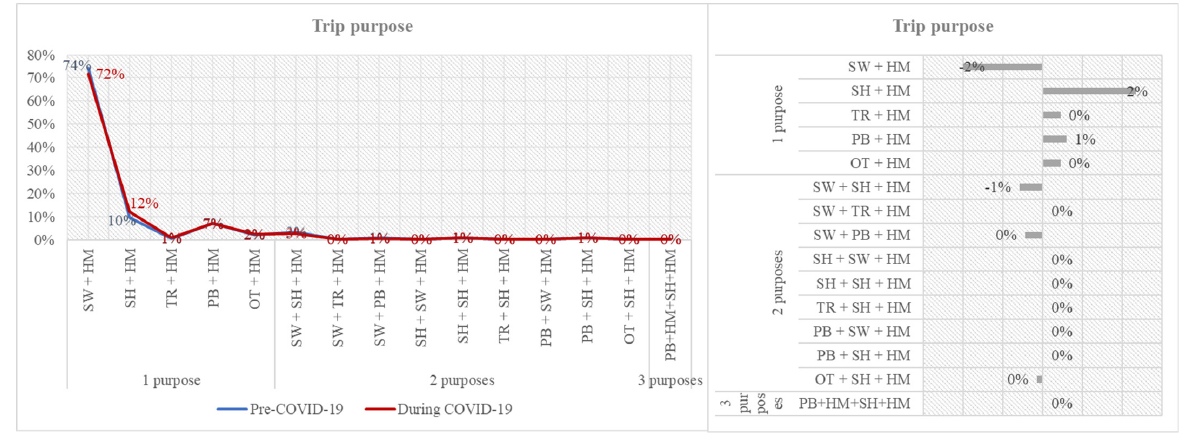
Figure 2. Comparison of trip purpose in pre-COVID-19 (TP1) and during COVID-19 period (TP2).